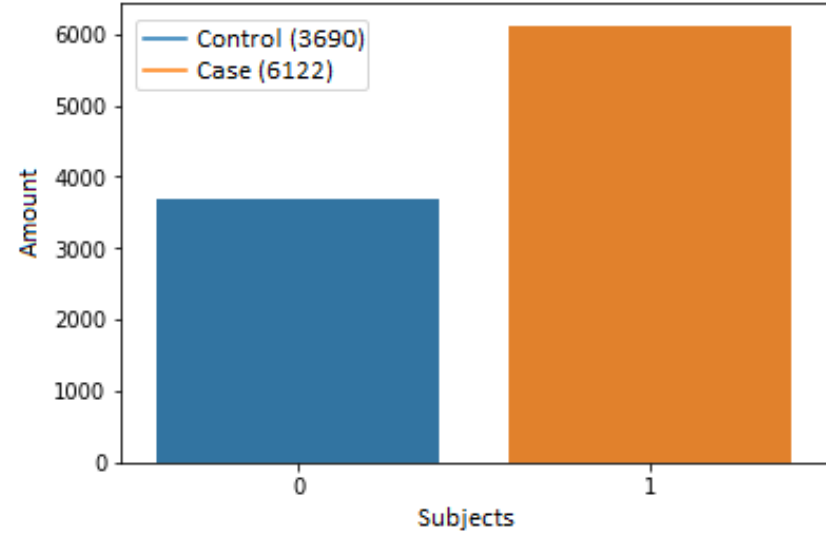
Figure 3. Graph of the total number of subjects used, classified according to their oral health status. The subjects contained in the bar with ’0’ presented absence of caries, while the subjects contained in the bar with ’1’ presented presence/restoration of